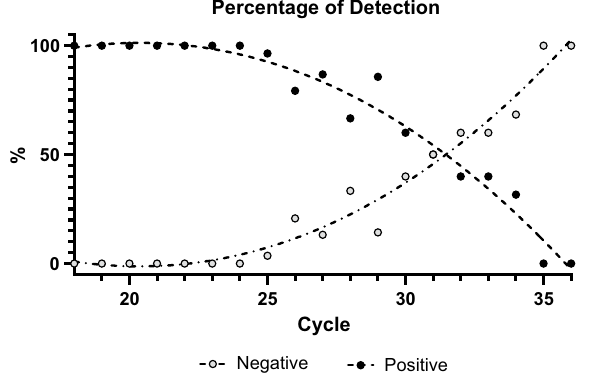
Figure 1. ( A ) The percentage of PCR positive samples that were found positive by RATs decreases as the PCR cT increases and the percentage of RAT-negative/PCR-positive samples is rising. 50% of samples are correctly identified as positive at cT = 31.5. ( B ) A significantly larger part of the RAT positive cases has cT values in the mid and lower range, while the highest cT values were more often observed in RAT negative